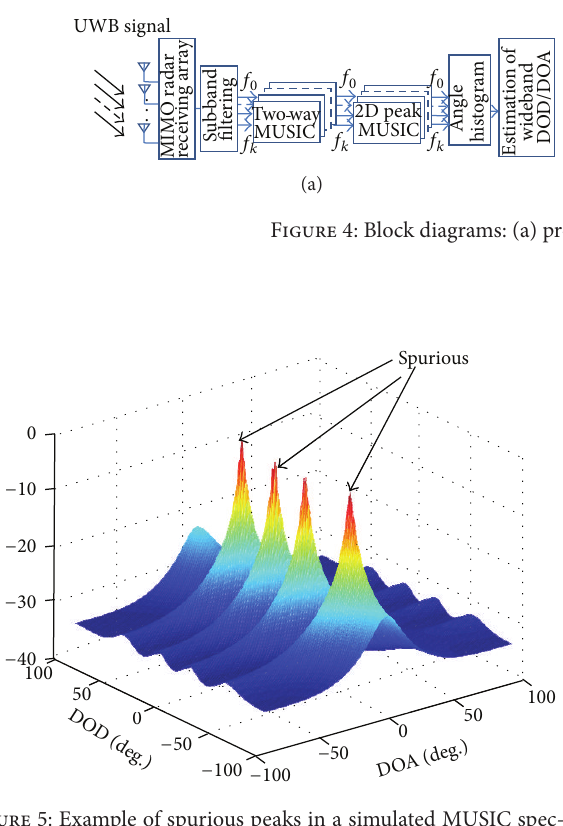
Figure 5: Example of spurious peaks in a simulated MUSIC spec- trum ( 𝑓 𝑘 = 5.0